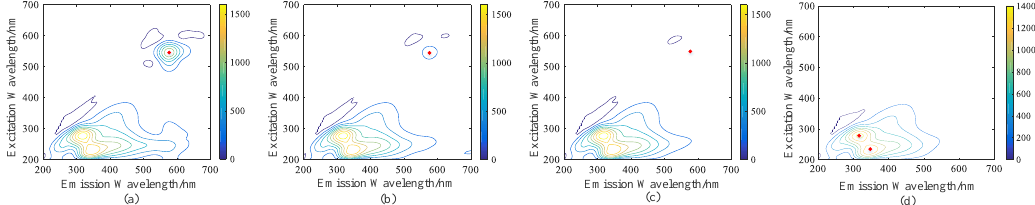
Figure 2. Spectral images of ( a ) 40 μg/L salicylic acid; ( b ) 10 μg/L salicylic acid; ( c ) 4 μg/L salicylic acid; and ( d ) drinking water.